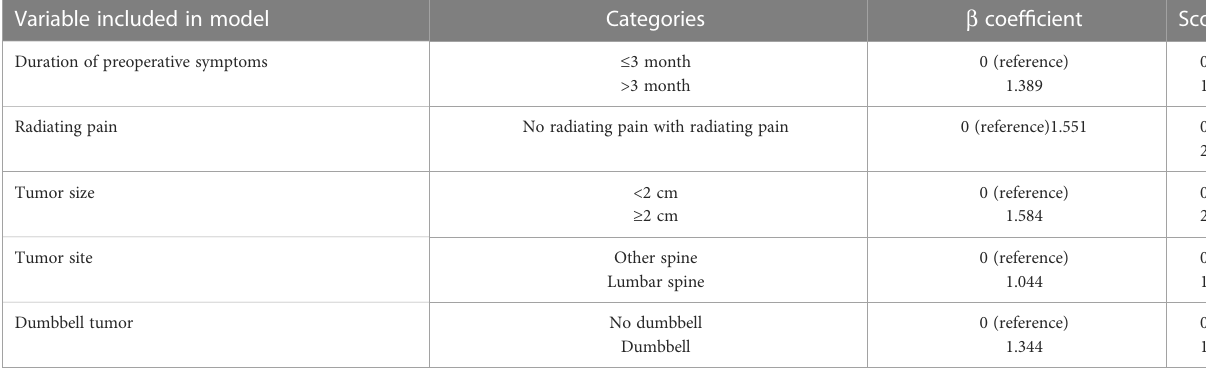
TABLE 5 Scoring System derived from the b coef fi